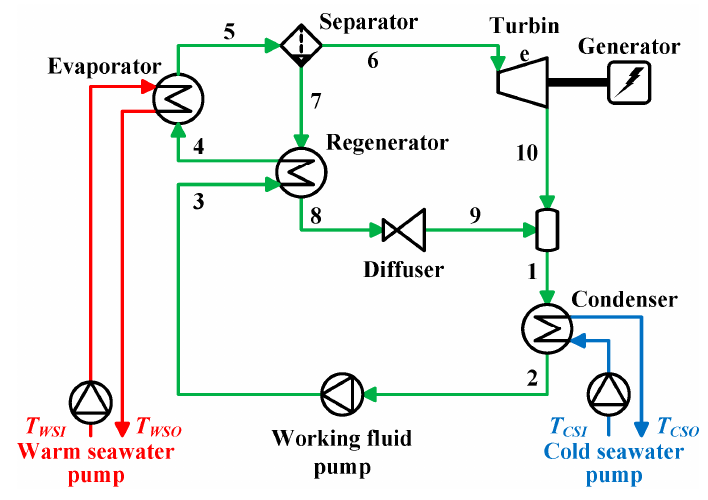
Figure 5. Kalina cycle flow.